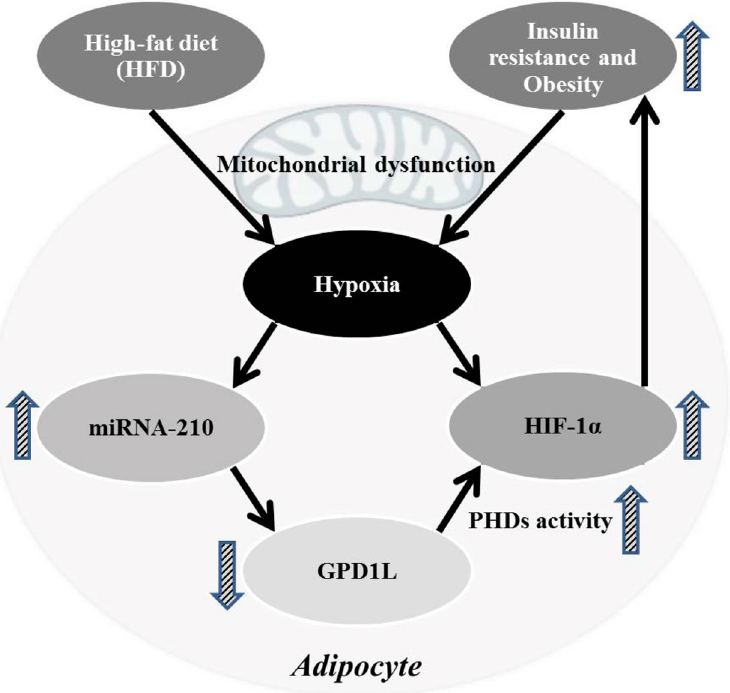
Figure 5. A potential mechanism of HFD-induced obesity based on hypoxia-induced feedback loop with miRNA-210 regulating GPD1L . During HFD, the oxygen levels decreased (a state of relative hypoxia), HIF-1 α protein and transcriptional activity increased, triggering accumulation of miR-210. Increased miR-210 caused decreased GPD1L protein and a further inactivation of the PHDs, resulting in increased HIF-1 α protein. Overexpression of HIF-1 α developed insulin resistance with increased adipose tissue inflammation, resulting in fat accumulation and obesity. Obesity aggravated the hypoxia, resulting in a feedback regulatory